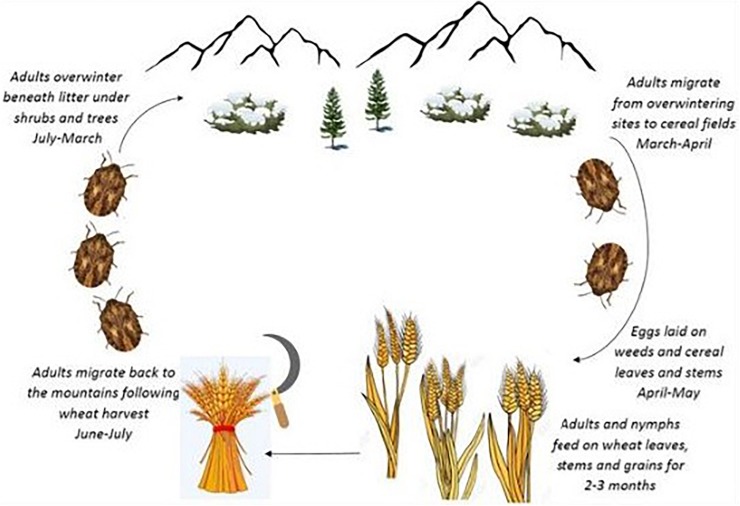
Life cycle of Eurygaster integriceps “adapted with permission” from Davari and Parker (2018).